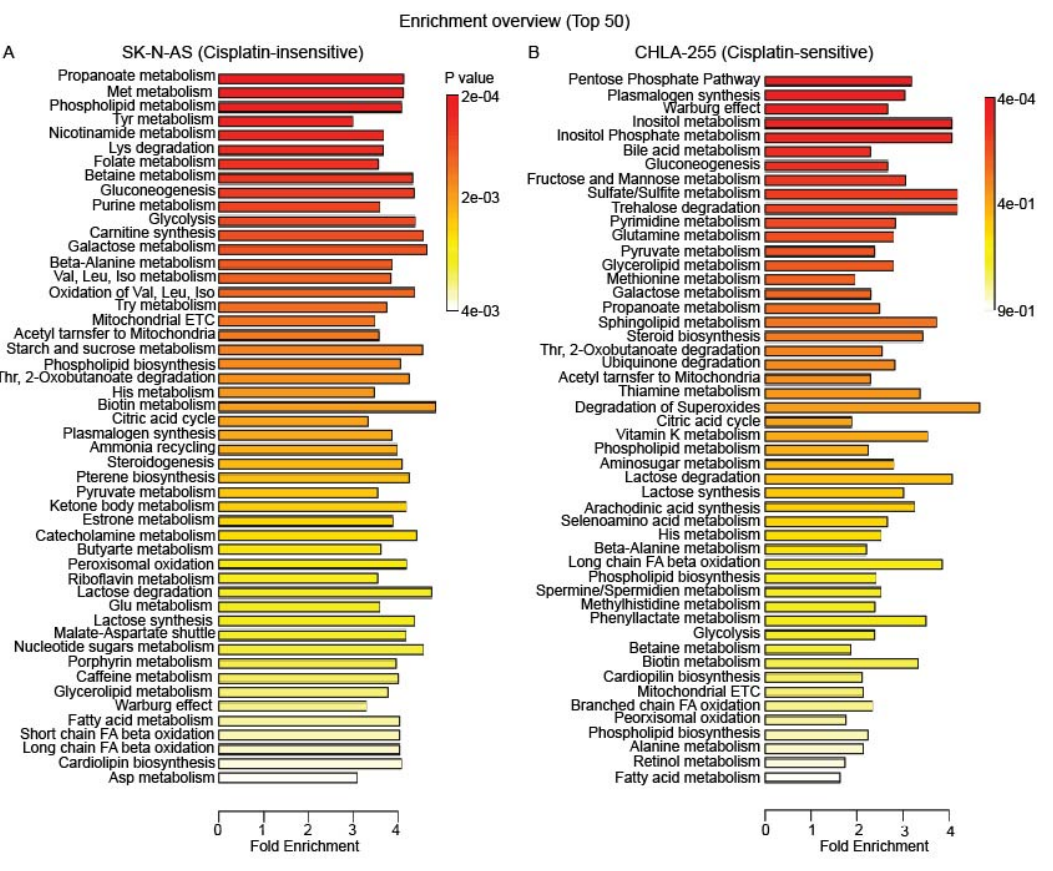
Figure 2. Cisplatin treatment affects metabolic pathways in neuroblastoma cells. The pathway impact analyses showing top 50 metabolic pathways altered in ( A ) cisplatin-insensitive, SK-N-AS and ( B ) cisplatin-sensitive, CHLA-255 cells upon cisplatin treatment. Three biological replicates were used in each condition. The scale under the plot, indicates fold enrichment for each plot, whereas the color scale adjacent to the respective plot indicates p -values for the impacted pathways.